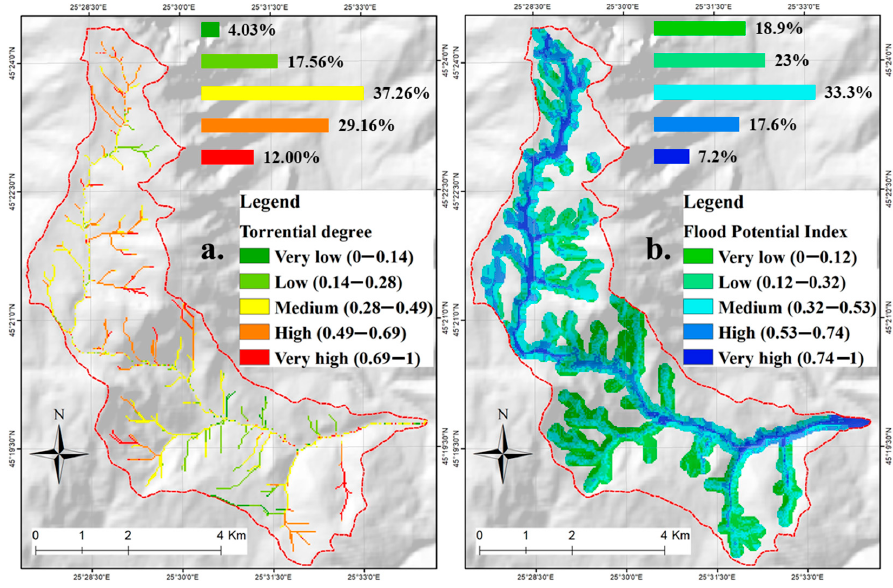
Figure 8. ( a ) River valleys torrential degree of the river; ( b ) Flood potential index classes.